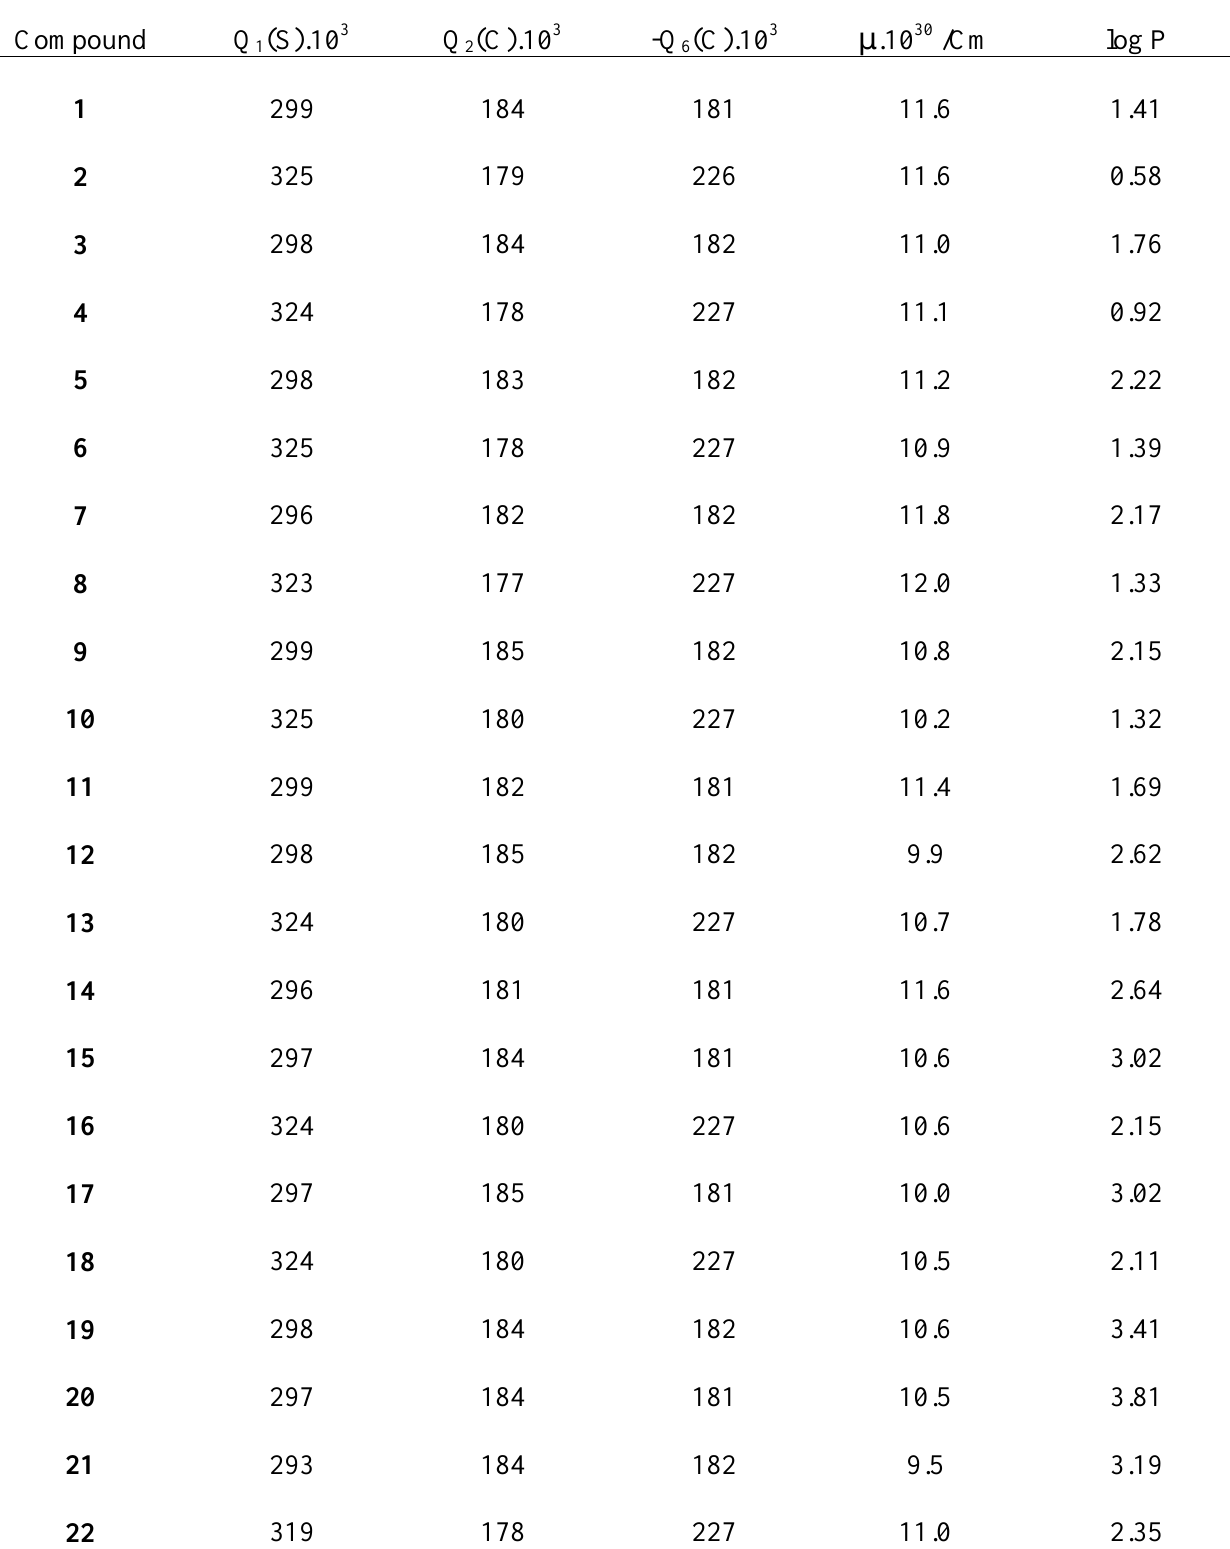
Table 2. Calculated atomic charges and dipole moments by AM1 method and theoretical values log